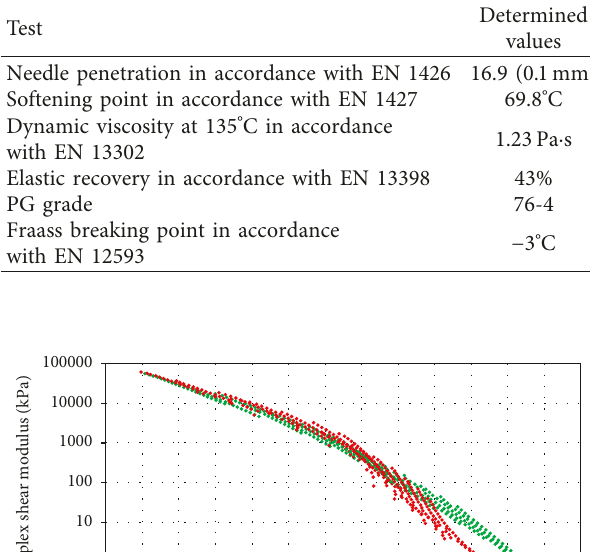
Table 2: Basic properties determined for reclaimed binder from RA of gradation 0/11mm (RAP) for SMA 11.